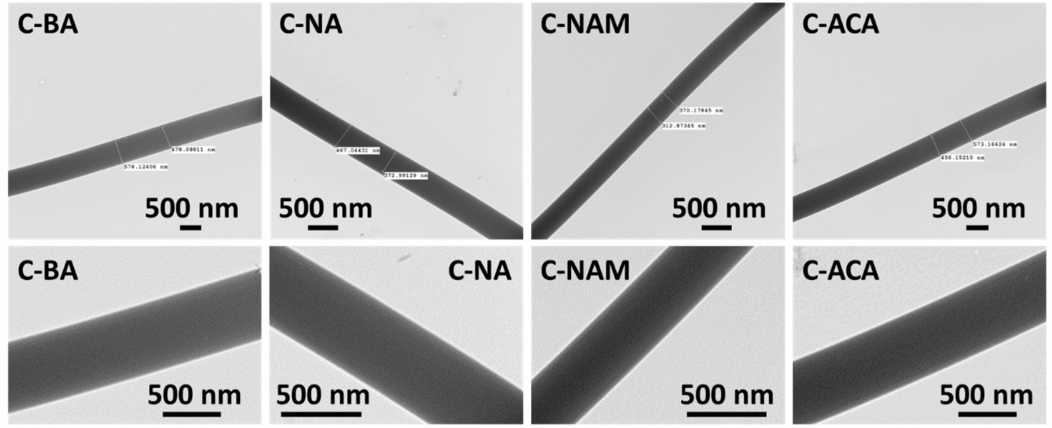
Figure 6. TEM images of the coaxial fibers.